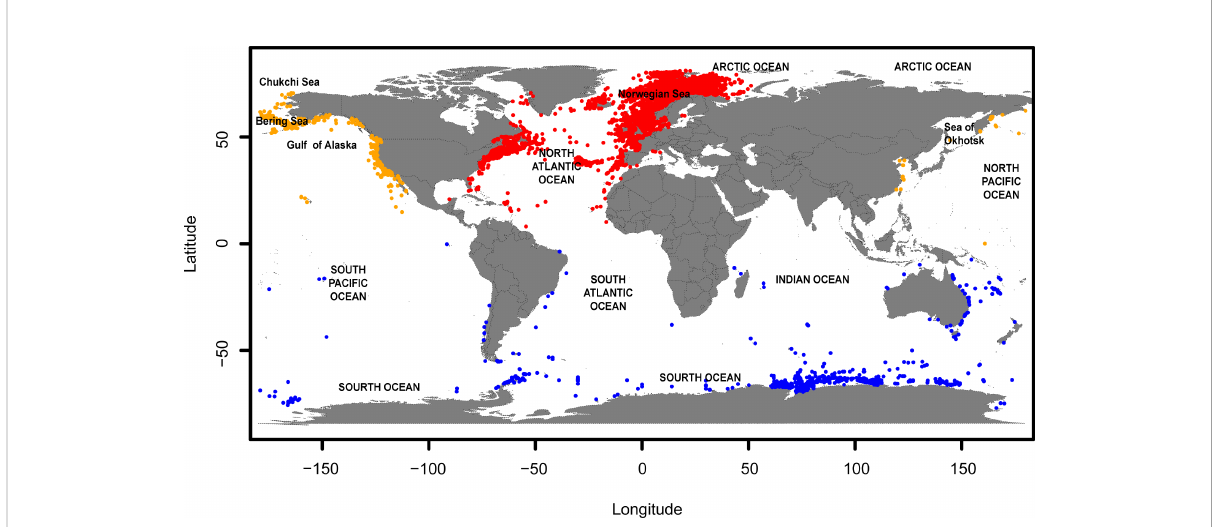
FIGURE 1 Map of study regions and occurrence records of the common minke whale. Red dots, orange dots and blue dots indicate the occurrence records of the North Atlantic population (NAP), the North Paci fi c population (NPP) and the Southern Hemisphere population (SHP),